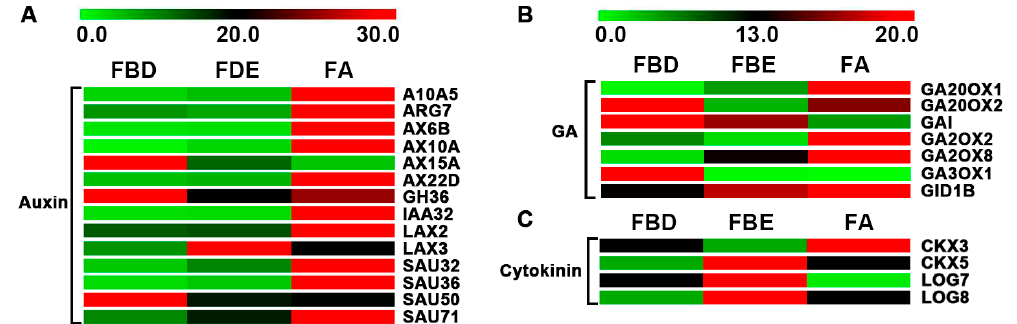
Figure 3. Kyoto Encyclopedia of Genes and Genomes (KEGG) pathway enrichment analysis of DEGs. ( A ) Enrichment analysis of DEGs for floral bud elongation (FBE) vs. flower bud di ff erentiation (FBD). The pathway of plant hormone signal transduction was mainly enriched (black arrow). ( B ) Enrichment analysis of DEGs for floral anthesis (FA) vs. FBE. The pathways of plant hormone signal transduction (black arrow) and starch and sucrose metabolism (green arrow) were mainly enriched. Rich factor is a ratio of the number of DEGs annotated with a pathway relative to the total number of genes annotated with this pathway. The larger value of the rich factor represented, the greater the enrichment of this KEGG pathway.